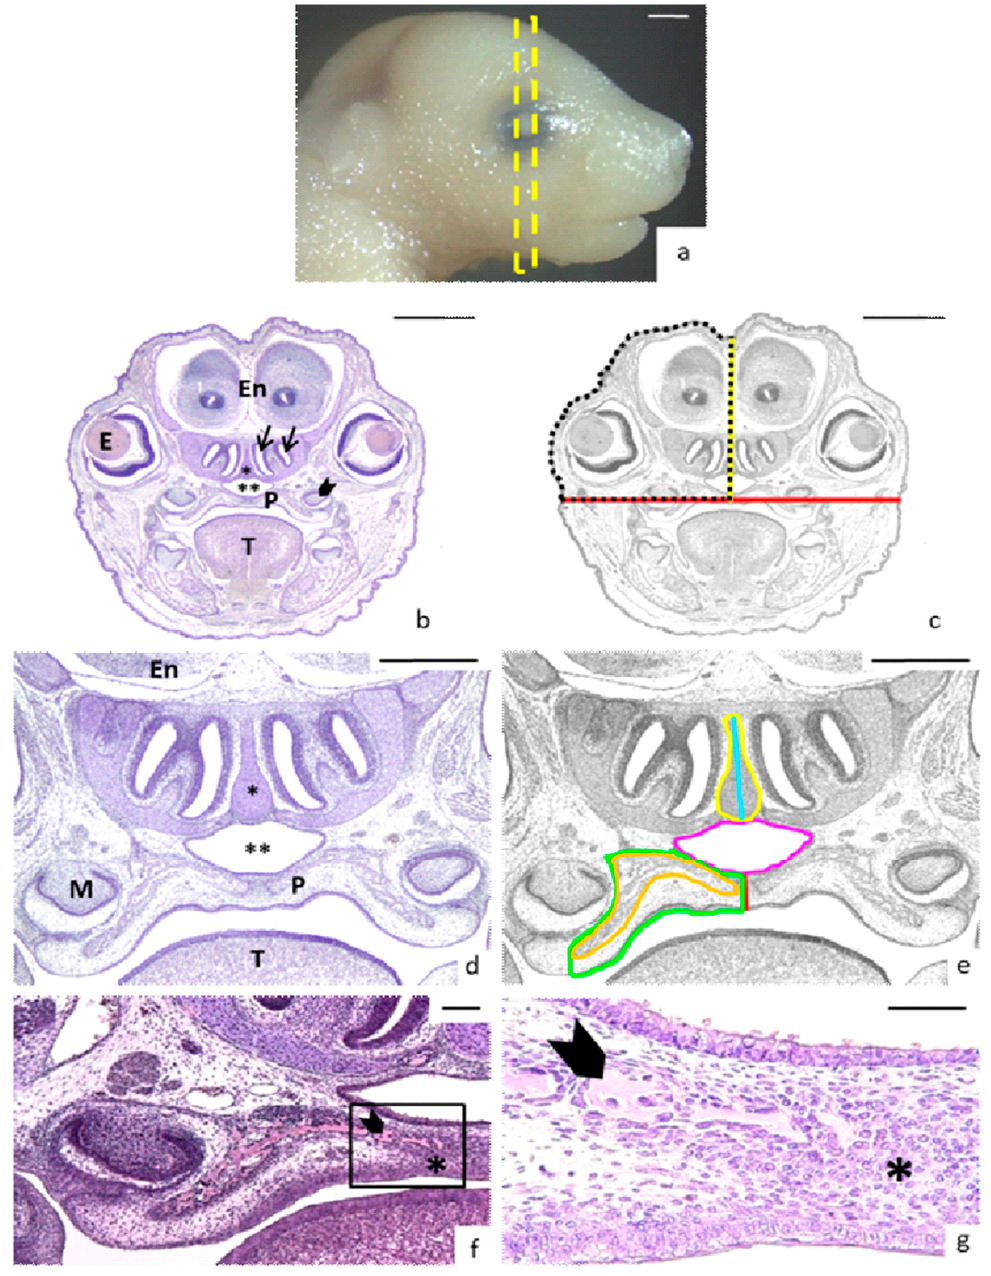
Figure 1. Head and nasopalatine region measurements. ( a ) Lateral view of a control head E17-fetus. The yellow rectangle crossing the eye indicates the block of sections selected for measurements. ( b ) Coronal section showing the landmarks for measurements: The nasal meatus (arrows), the eyes (E) and the developing molars (arrows heads) (En: encephalon; P: palate; T: tongue; asterisk: nasal septum; double asterisk: nasopharynx). ( c ) Description of head measurements on the same black and white image: width (red line), height from palate to top of the head (yellow line) and area of the half head (discontinuous black line). ( d ) Magnification of the nasopalatine region (T: tongue; P: palate; M: developing molar; double asterisk: nasopharynx; asterisk: nasal septum; En: encephalon). ( e ) Description of nasopalatine region measurements on the same black and white image: thick of the palate (red line); area of the half of the palate (green line); area of the bone tissue inside the palate area (orange line), area of the nasopharynx (pink line), area (yellow line) and height (blue line) of the nasal septum. ( f ) Magnification of the right half palate: bone tissue (arrowhead) and the osteogenic condensation (asterisk). ( g ) Magnification of the rectangle marked in ( f ): bone tissue (arrowhead) and the osteogenic condensation (asterisk). Scale bars: ( a – c ) 1 mm; ( d – e ) 500 µm; ( f ) 100 µm; ( g ) 50 µm.